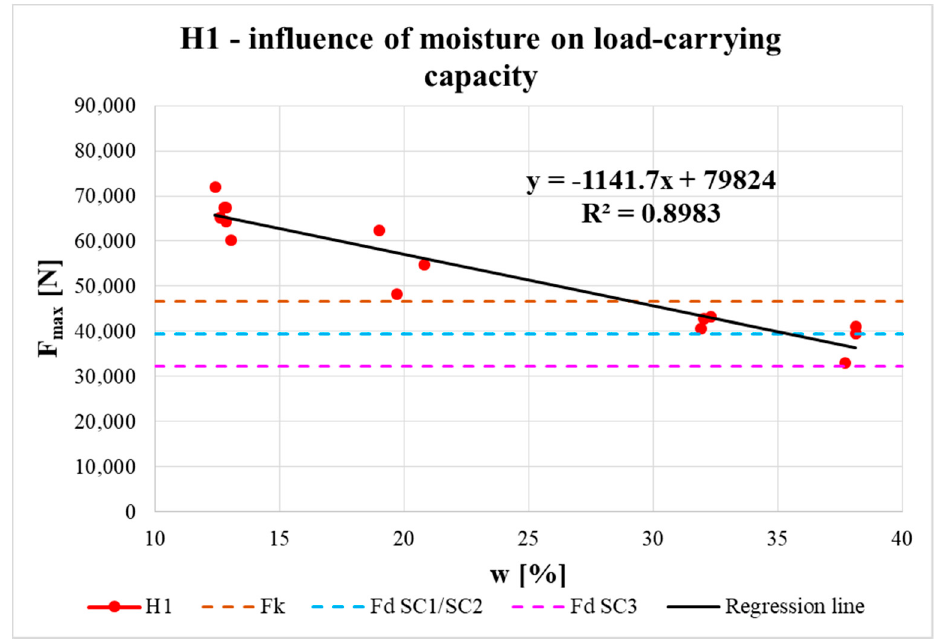
Materials 2020 , 13 , x FOR PEER REVIEW Figure 17. Influence of moisture content on load-carrying capacity of H1 specimens.